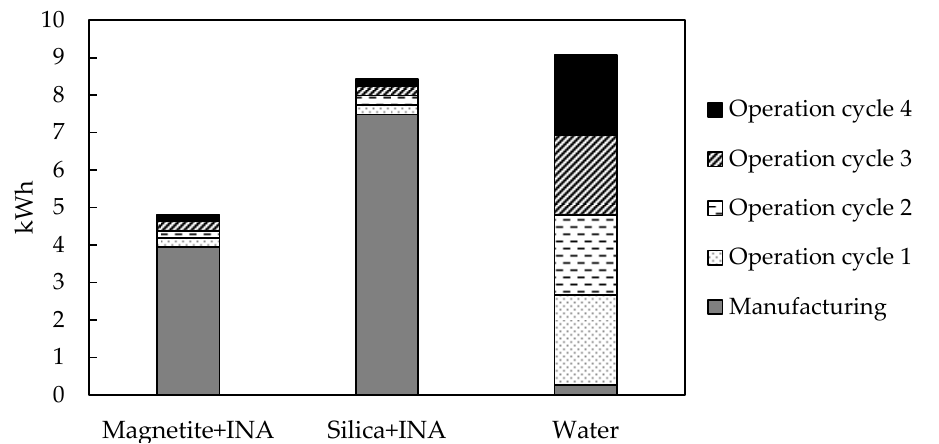
Figure 3. Energy consumption of the operation stage during four work cycles.